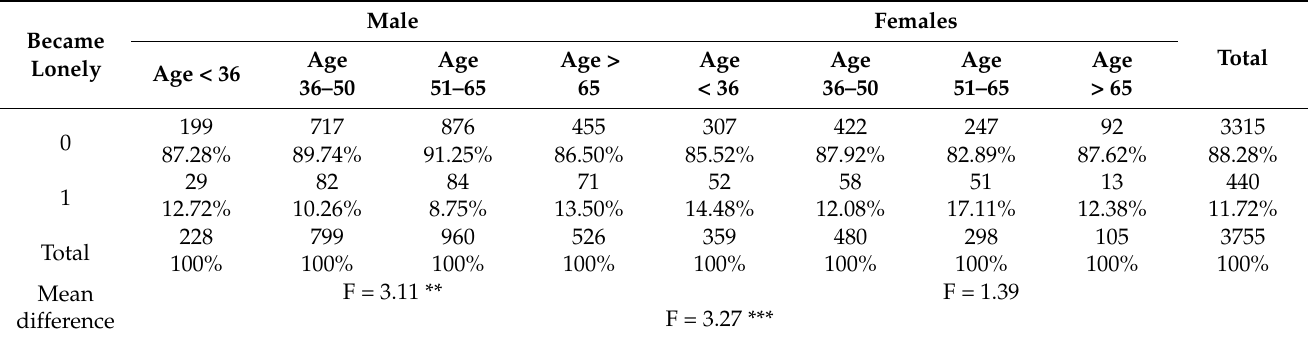
Table 4. Became lonely, stratified by gender and